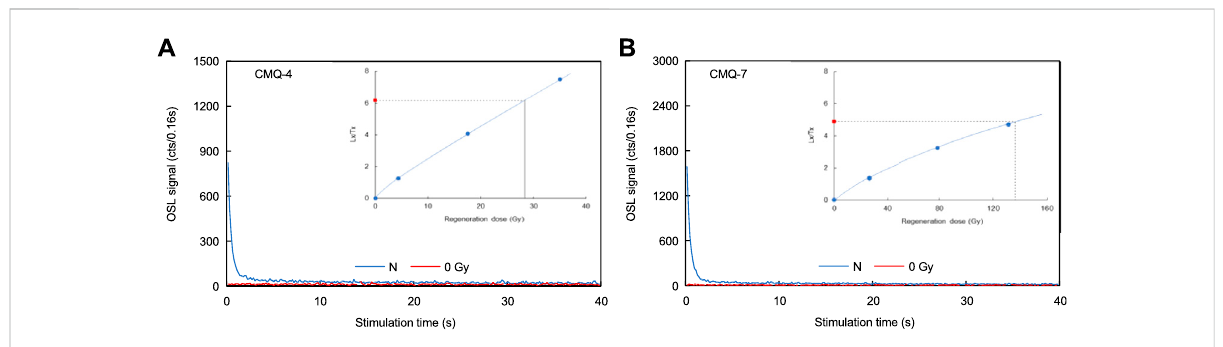
FIGURE 4 Growth and decay curves for the samples (A) CMQ-4and (B) CMQ-7 from theCMQ and ZHK pro fi les in the Yellow River source area on theNE Tibetan